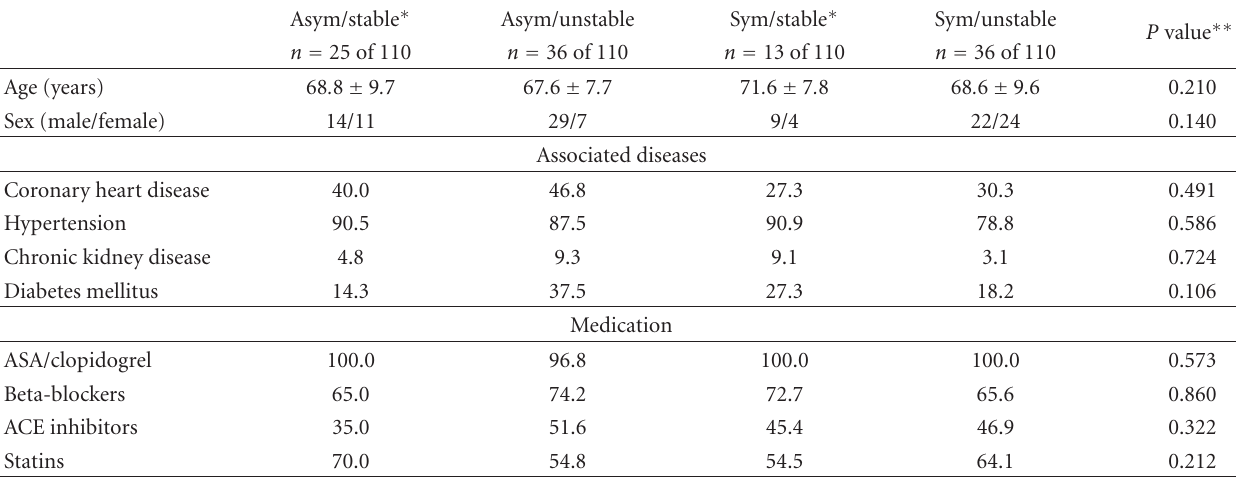
Table 1: Patients characteristics.